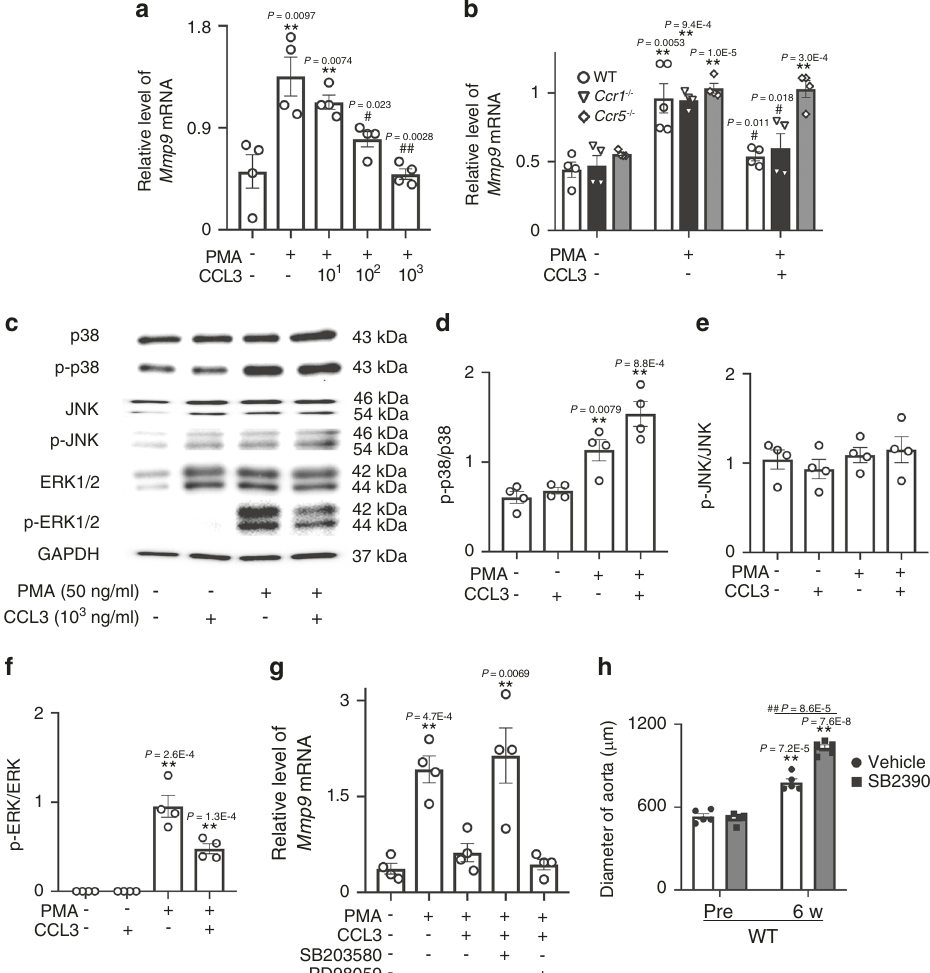
Fig. 8 Regulation of MMP-9 expression in peritoneal macrophages by CCL3 and its receptors. a The effects of CCL3 on Mmp9 expression in WT macrophages stimulated by PMA for 24 h ( n = 4 independent experiments). ** P < 0.01, * P < 0.05, vs. no stimulation; ## P < 0.01, # P < 0.05, vs. PMA